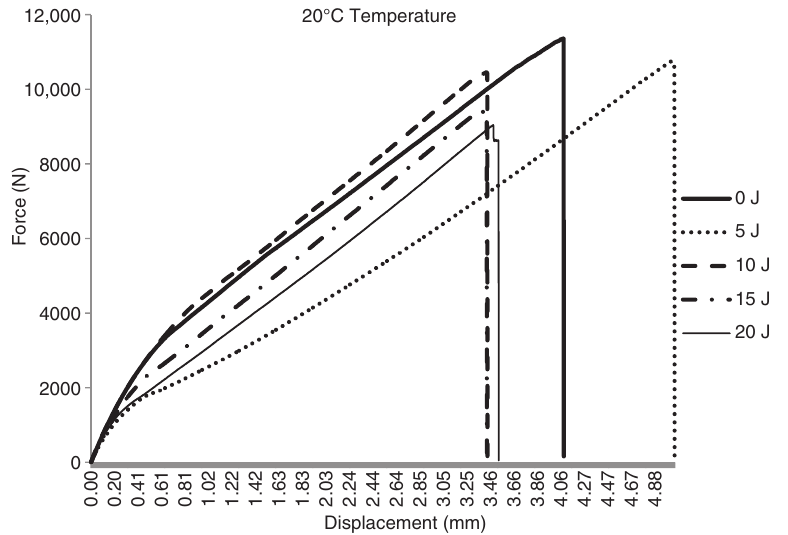
Figure 6: Effects of different impact energy values on load-displacement response at the 20 ° C temperature level.